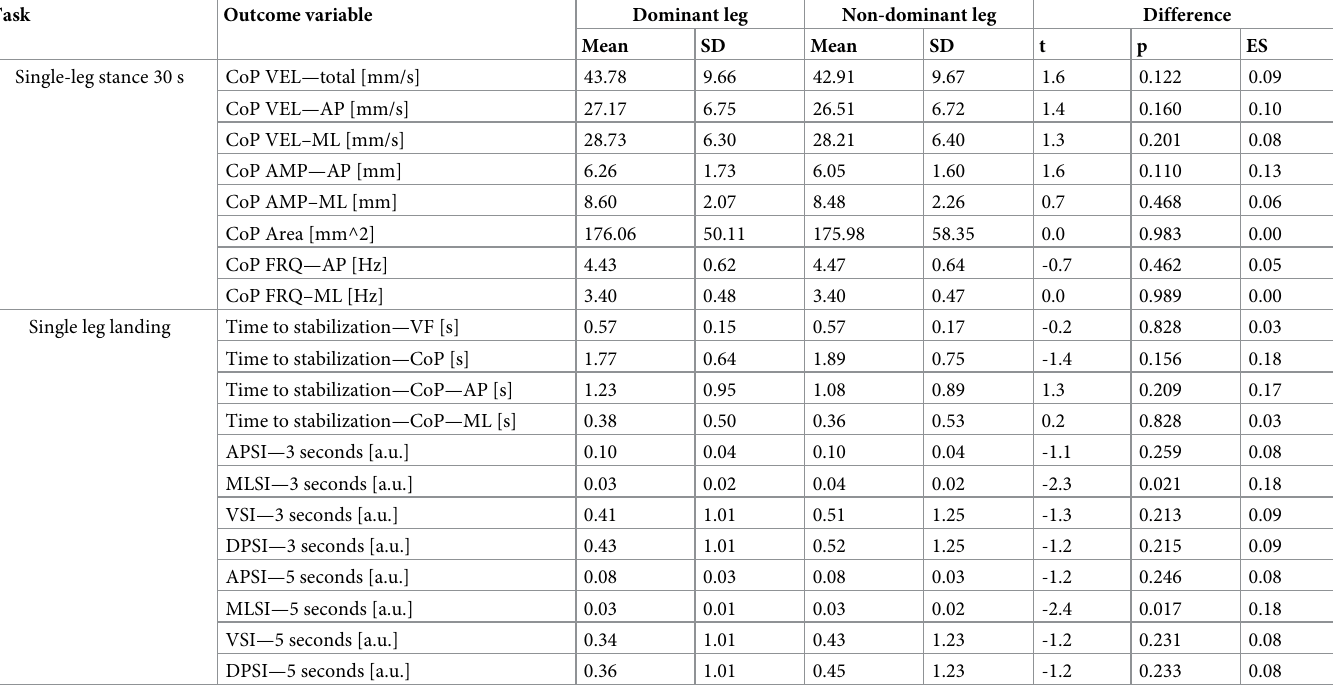
Table 4. Effect of leg dominance (based on dynamic postural stability index) on body sway and landing variables.